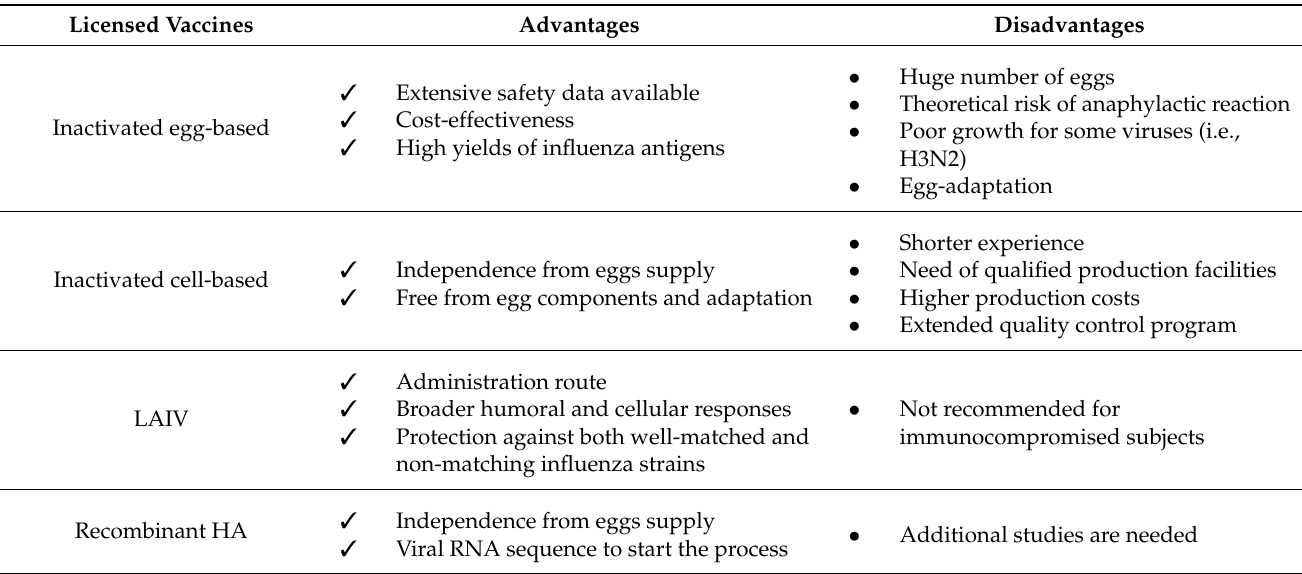
Table 1. Summary of advantages and disadvantages of licensed seasonal influenza